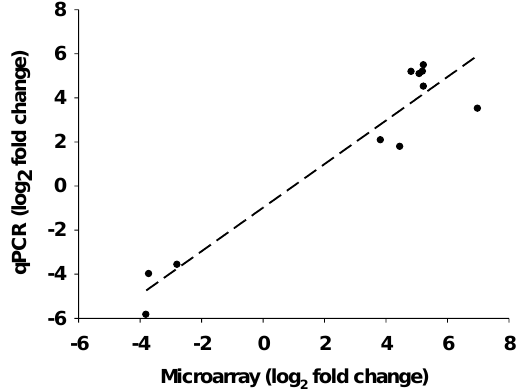
Figure 5. Comparison of the log 2 of the fold change in gene expression levels (Nod plants / NN plants) according to microarray and real-time PCR. The linear regression analysis carried out gave a regression coefficient of r 2 = 0.91.